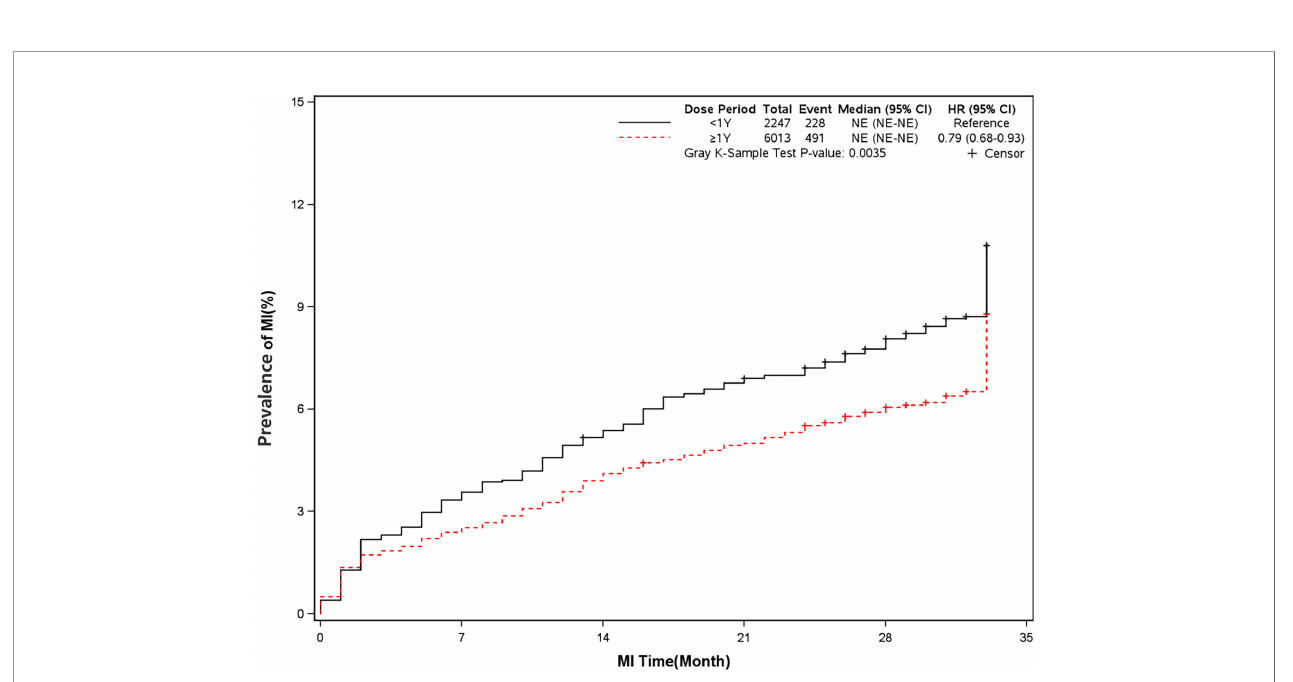
FIGURE 3 | Prevalence of recurrent myocardial infarction in two groups. Blackline: patients took clopidogrel continuously < 1 year; Red line: patients took clopidogrel continuously ≥ 1